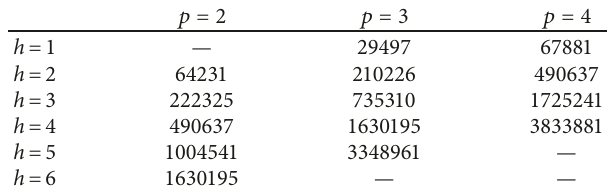
Table 4: DOF of different refinement levels of CASE.